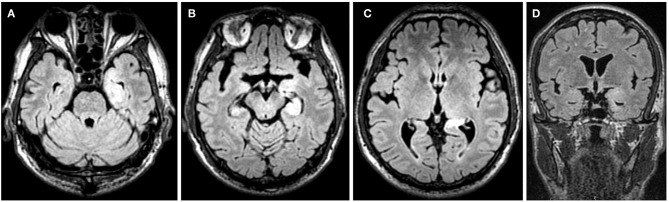
Case 17, male, 64 years old, who was diagnosed with anti-γ-aminobutyric acid B receptor (GABABR) encephalitis. (A–D) Twenty-one days after onset and before immunotherapy, brain MRI showed high T2/fluid-attenuated inversion recovery (FLAIR) signal in the left hippocampus.